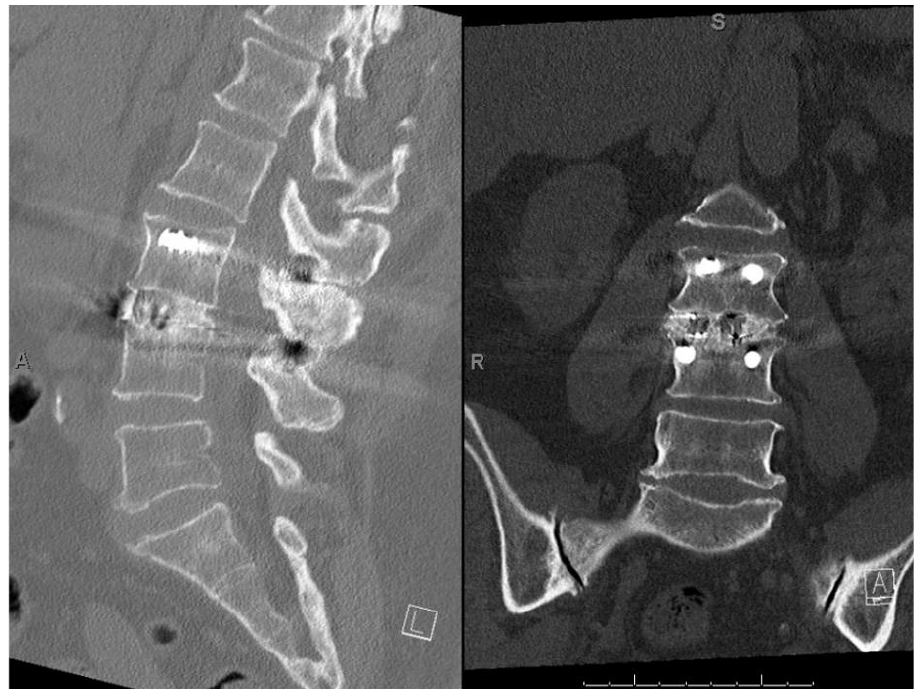
Figure 1. Spinal fusion success rate. A high rate of fusion success was observed in lack of motion + bridging bone, bridging bone only, and lack of motion only.